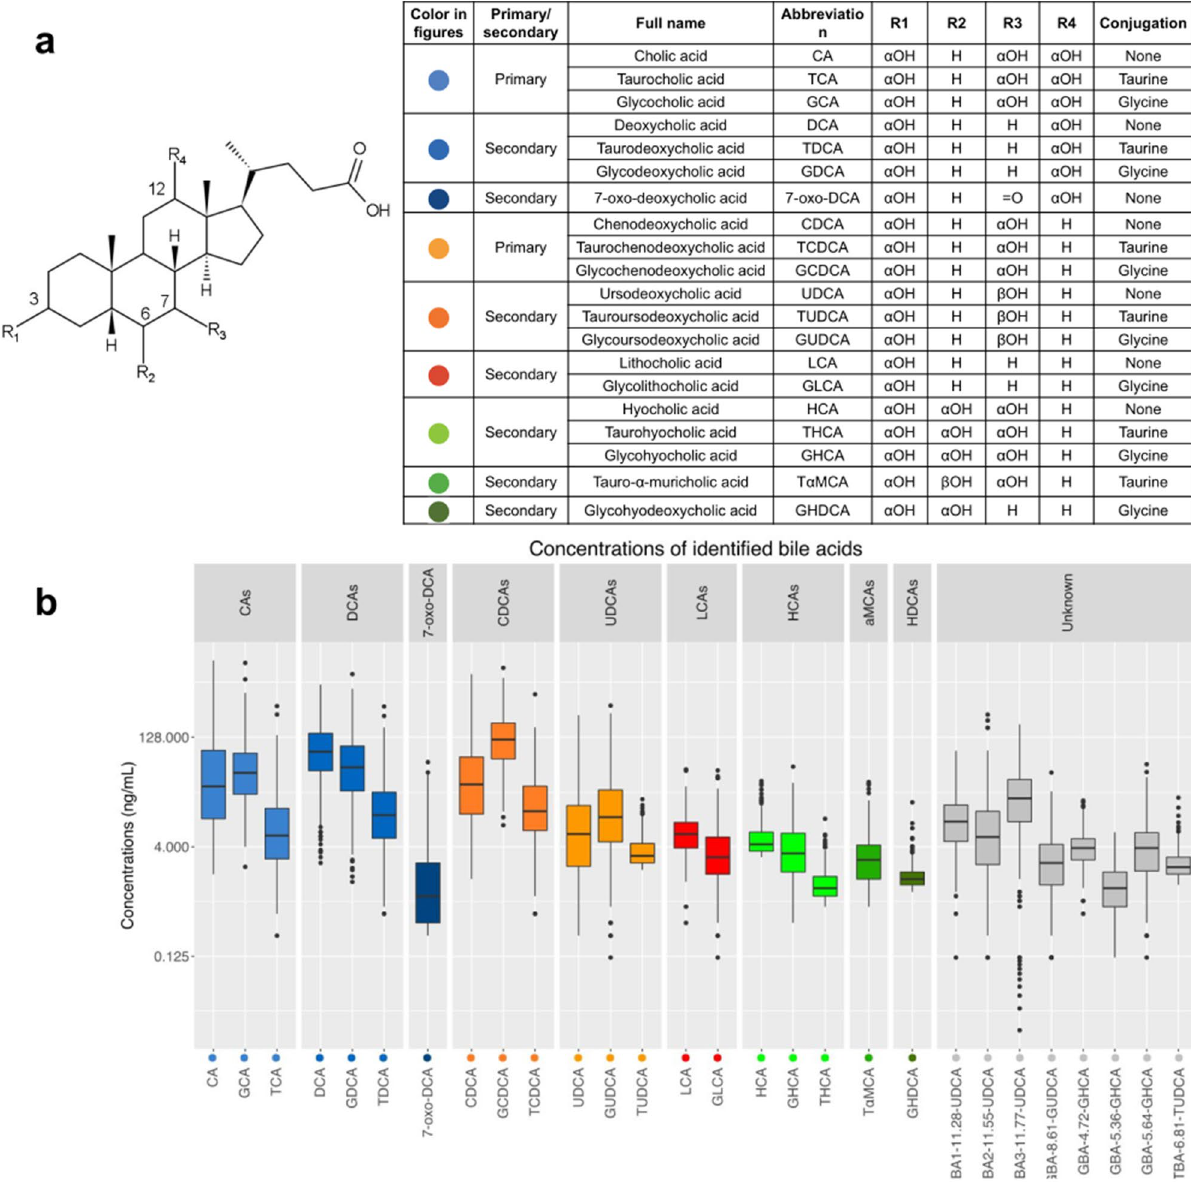
Figure 2. Chemical structures of bile acids and their concentrations in human fasting serum. ( a ) Summary of the structures and abbreviations of 20 serum bile acids with known chemical structure measured in the present study. We refer to the structure above for the positions of radical groups R1-4. The ‘αOH’ refers to an alpha- hydroxyl group pointing away from the reader, ‘βOH’ refers to a beta-hydroxyl group pointing towards the reader, ‘=O’ refers to a double bonded oxygen, ‘H’ refers to a hydrogen. Number refers to the number of a given carbon atom. Color-coding is chosen based on shared structural traits. Blue colors are for cholic acid (CA) and its metabolites with a R4 hydroxyl-group; red and orange colors are for chenodeoxycholic acid (CDCA) and conjugates with hydroxylations at R3 but not R4 position. Green colors are used for compounds with a hydroxyl group at R2 position. ( b ) An overview of the fasting serum concentrations of 20 bile acids of known chemical structures, and eight bile acids of ‘unknown’ structures from all the study participants. Abbreviations and bile acid names are shown in ( a